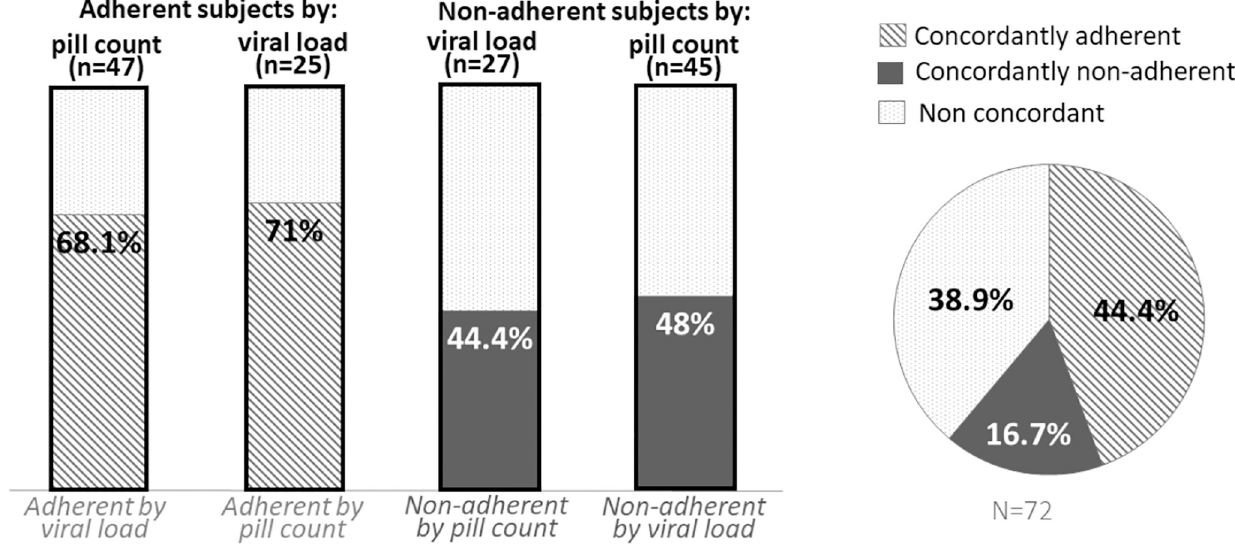
Fig 2. Agreement between the two measurement methods of adherence. The striped columns represent the percentage of agreement among adherent subjects, while the solid columns represent the percentage of agreement among the non-adherent ones. The pie chart on the right shows the percentages of agreement among the entire